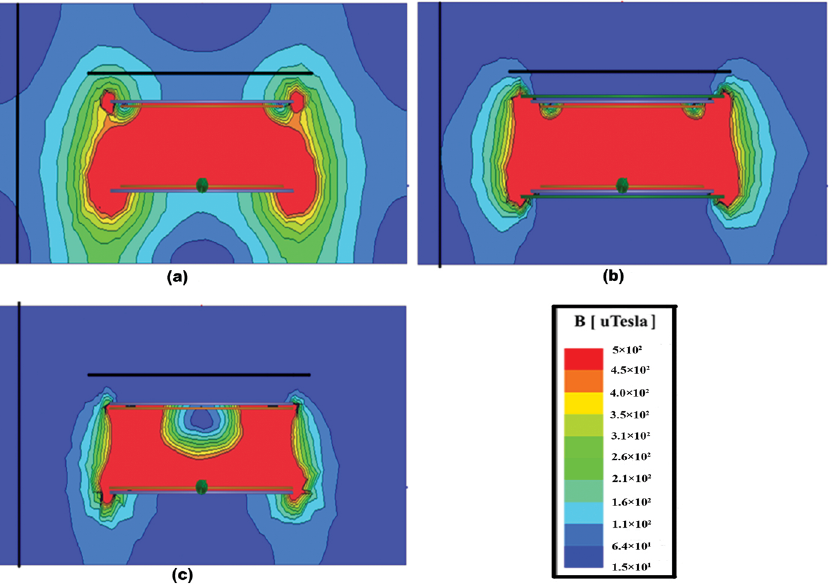
Figure 21. The magnetic flux density distribution ( µ T), ( a ) is the ferrite shield; ( b ) is the aluminum shield; and ( c ) is the resonant reactive current